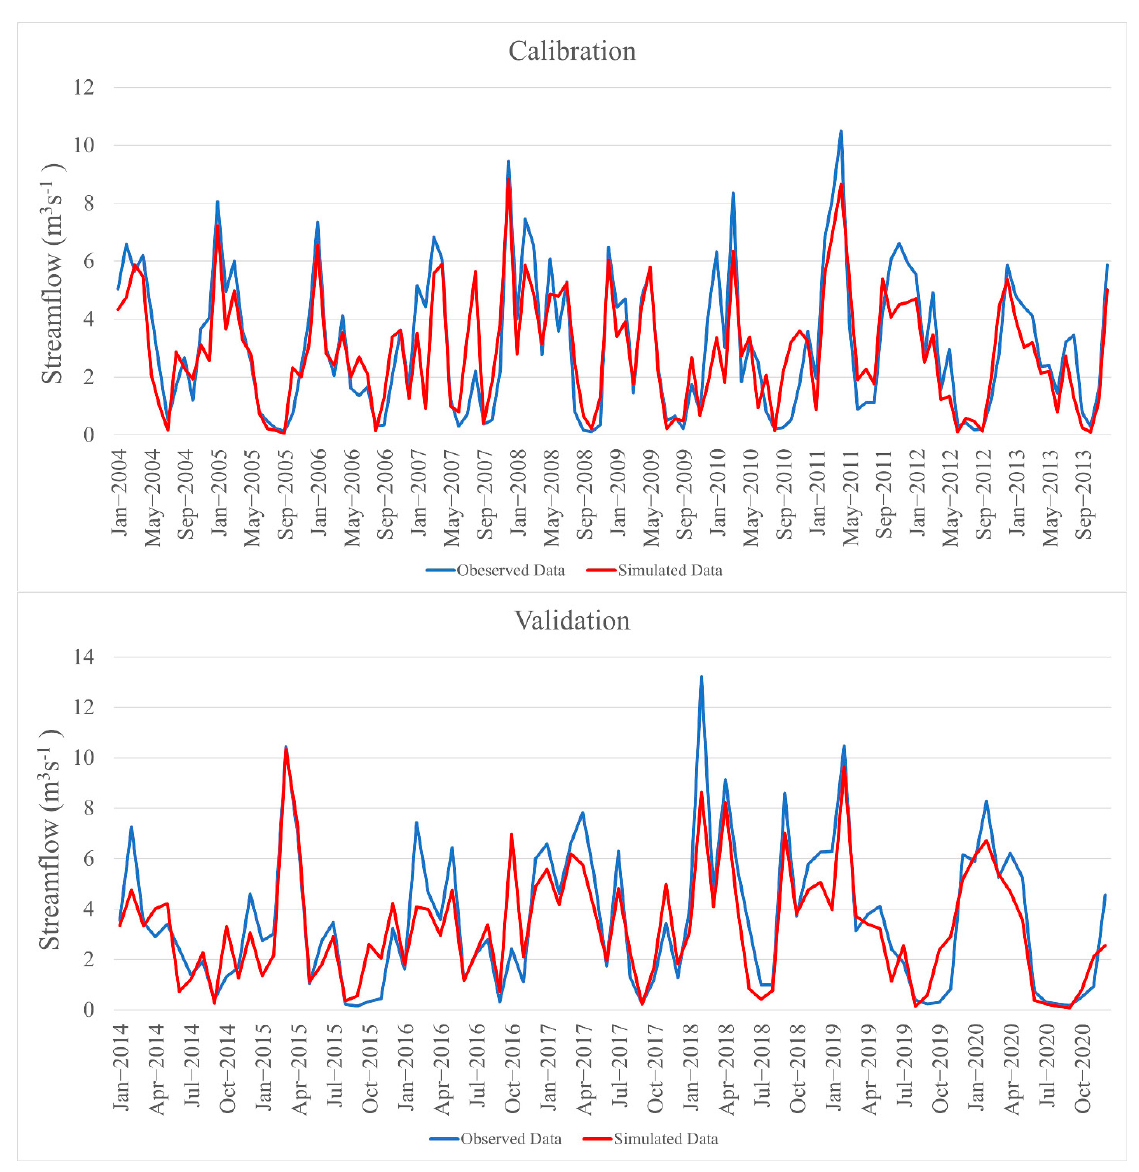
Figure 2. S imulated and observed streamflow during calibration and validation periods for Deckers Creek Watershed, Morgantown, West Virginia, USA. Creek Watershed, Morgantown, West Virginia, USA. Table 5. Projected minimum temperature (Tmin) and maximum temperature (Tmax) for three future periods (2030s, 2050s, 2070s) under two RCPs (4.5, 8.5) in DCW, Morgantown, WV, USA. Ensemble mean for four GCMs with the ensemble minimum and maximum values on the